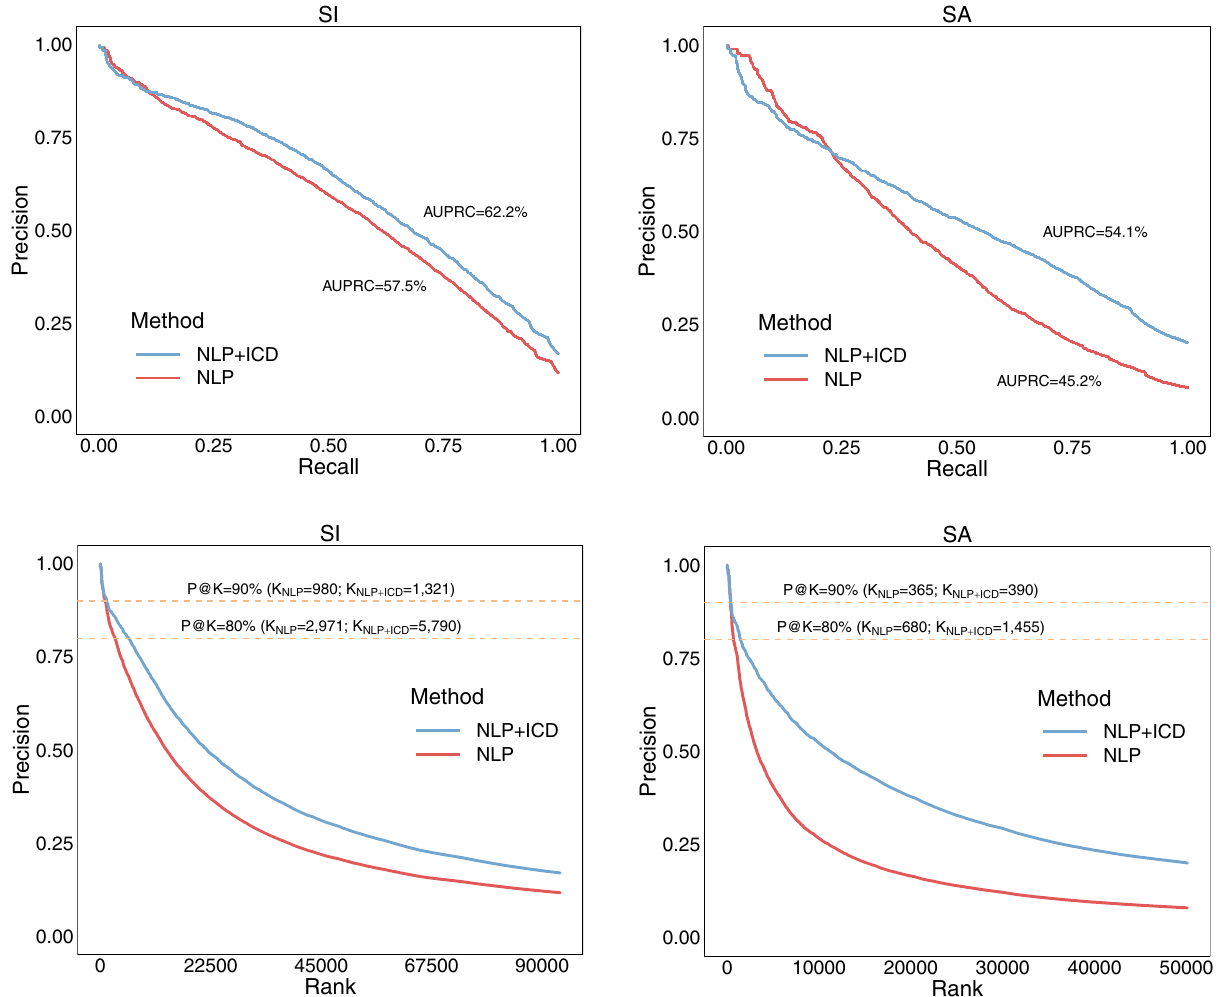
Figure 4. Evaluation comparing NLP and NLP + ICD label assignment methods for suicidal ideation (SI) and suicide attempt (SA). The patients used in this evaluation contain at least one positively asserted mention of suicide in their